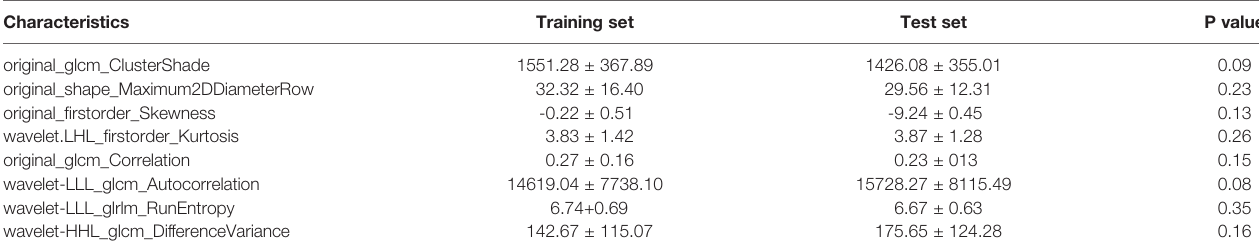
TABLE 2 | Analysis of the selected texture features in the training and test sets.